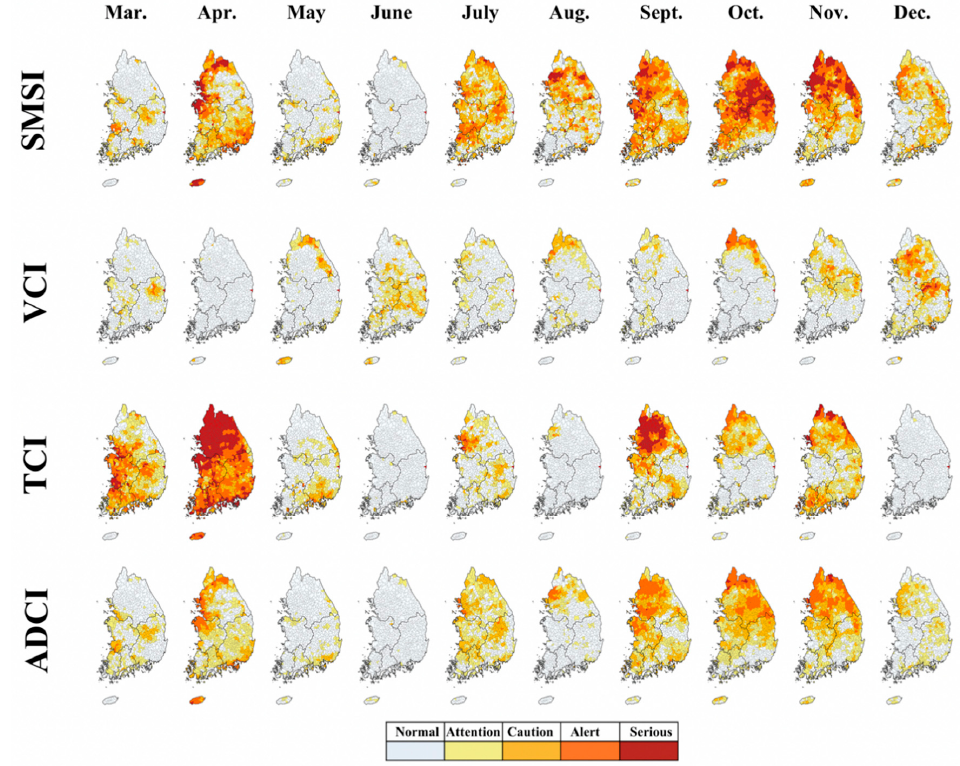
Figure 8. Spatial change of each drought index: SMSI, VCI, TCI, and ADCI for the 2014 drought.